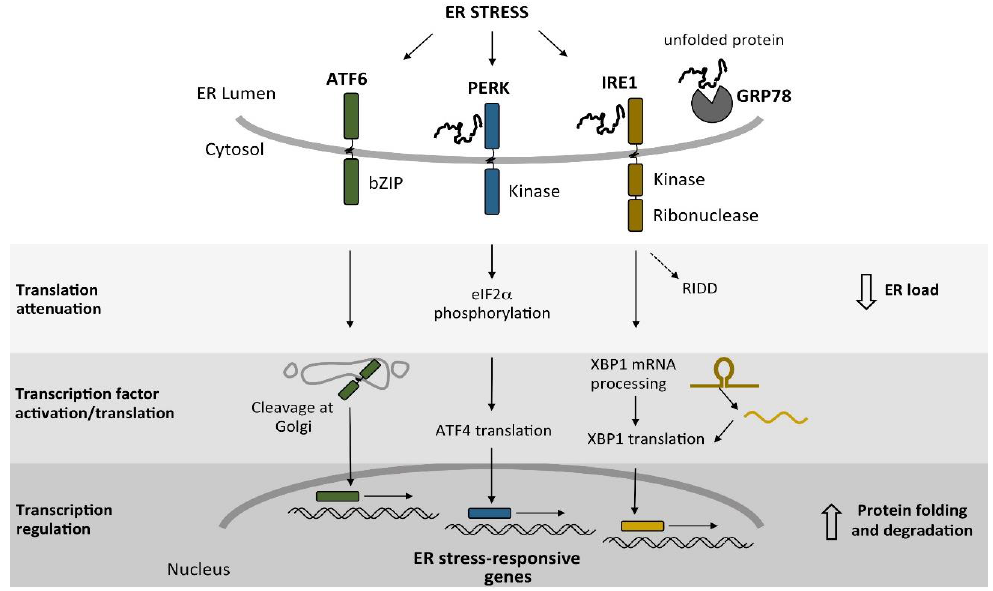
Figure 3. Signaling pathways involved in the unfolded protein response (UPR). In mammalian cells, three signaling branches that depend on the ER transmembrane sensor proteins—activating transcription factor 6 (ATF6), protein kinase RNA-like ER kinase (PERK), and inositol-requiring enzyme 1 (IRE1)—are activated upon ER stress (ERS). PERK and IRE1 can sense ERS by interacting directly with unfolded proteins through their luminal sensor domain. In addition, ATF6, PERK, and IRE1 detect an increase in unfolded proteins when they lose their association with the ER chaperone GRP78/binding immunoglobulin protein (BiP). When these transducers detect ERS, a recovery response is